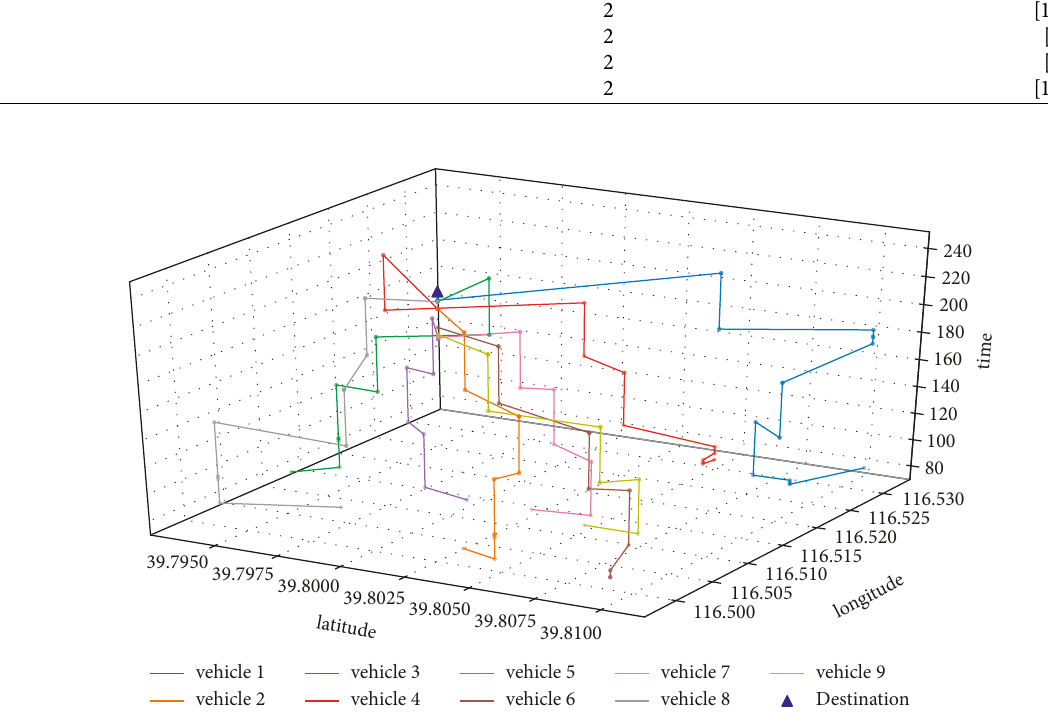
Figure 14: Optimal space-time route when τ � 80. Table 14: Comparison of the solution results under two service